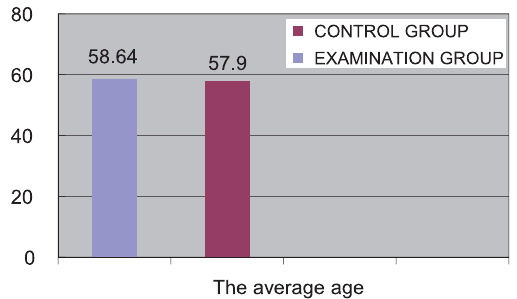
FIGURE 1. The average age of women without estrogen de- fi ciency in menstrual history t = 0.746, no statistically signi fi cant